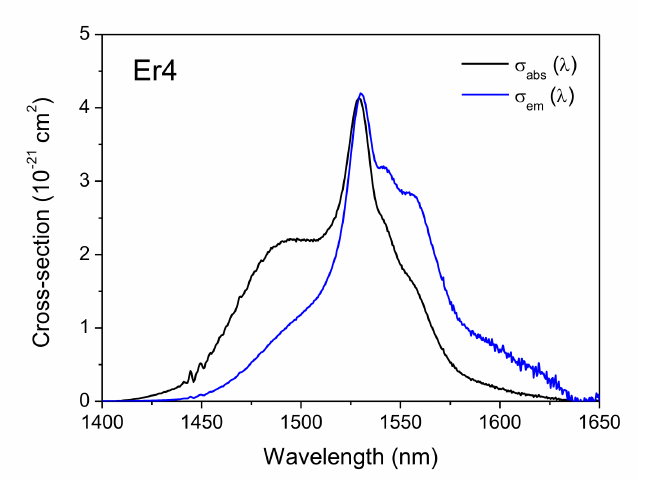
Figure 5. Absorption and emission cross-section for the aluminosilicate glass doped with 4 wt% of Er 2 O 3